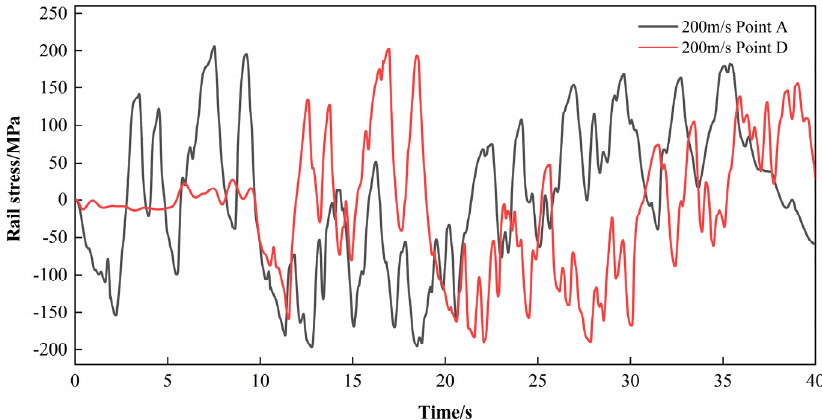
Figure 13. The stress–time-history curve of the rail at point A and point D when the apparent wave velocity is 200 m/s.